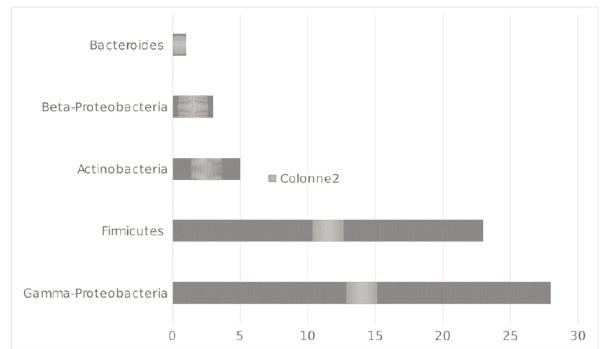
Fig. 1 - Classification of rhizospheric bacteria of Ucria on the PGP traits. The main bacteria divisions of plant growth pro- moting rhizobacteria from the rhizosphere of ucria.